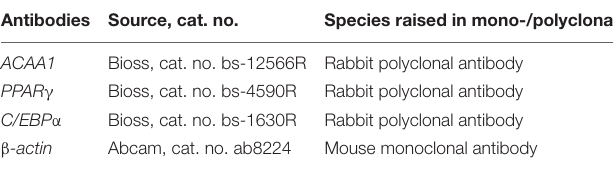
TABLE 3 | Antibodies used for Western blot analysis. Antibodies Source, cat.